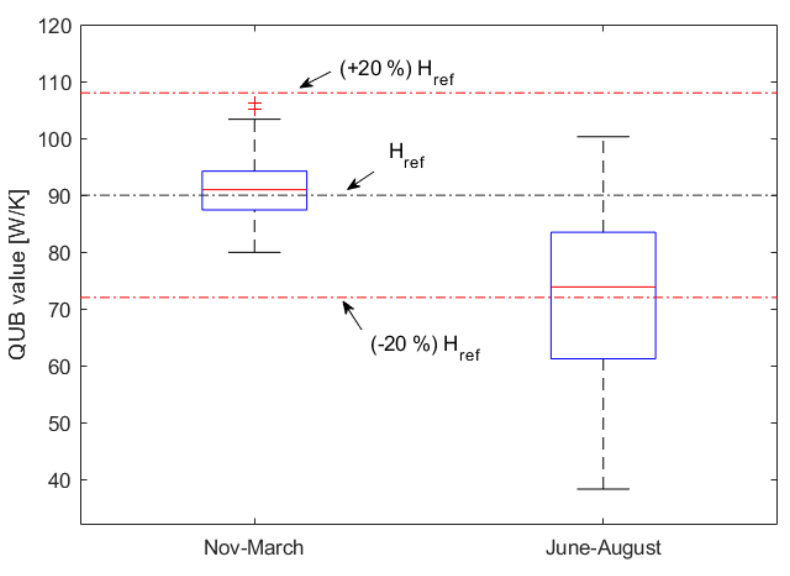
Figure 8. Errors of QUB experiments performed during winter and summers.